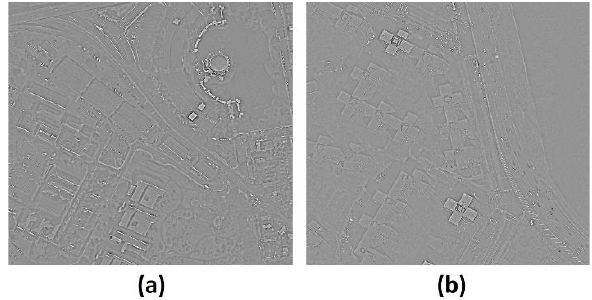
Figure 8. Detail layers: (a) San Francisco dataset, (b) NY